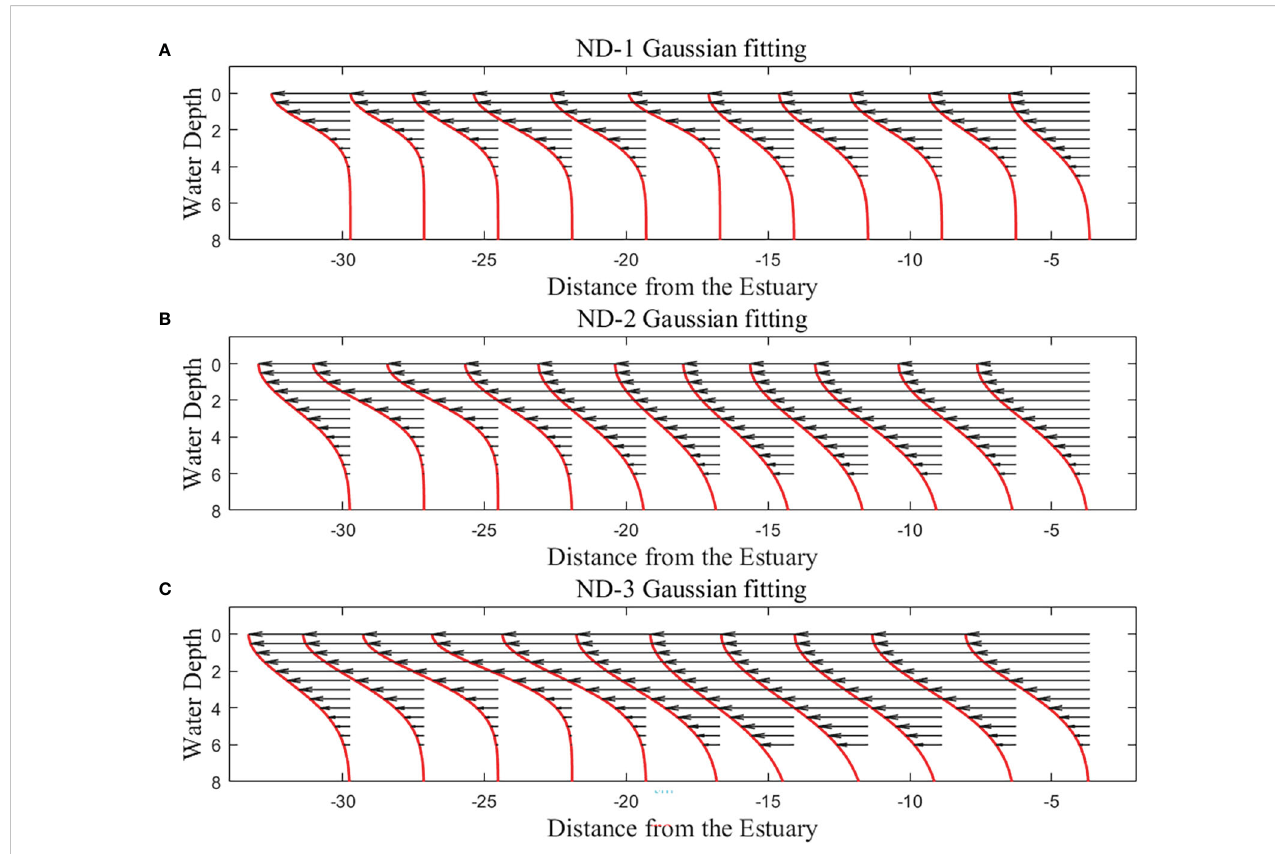
FIGURE 5 Gaussian distribution of horizontal velocity of ND groups: Case ND-1 (A) , Case ND-2 (B) and Case ND-3 (C)